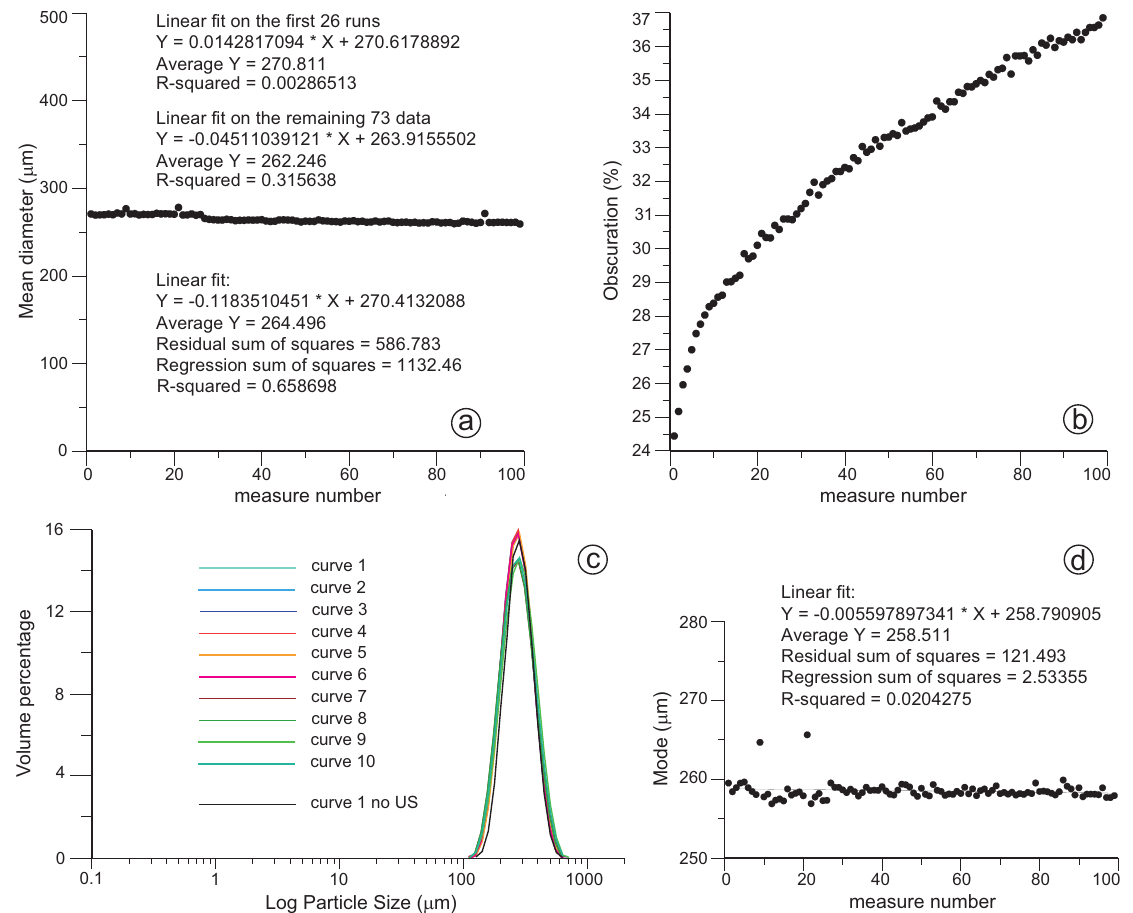
Fig. 15. Results of the ultrasonication test US20 5 performed on sub-sample aliquot SAND1d by the Hydro 2000 MU dispersion unit. (a) Mean diameter value evolution with increasing the number of measurement runs. Data statistics are provided for the cumulative dataset, for the first 26 runs, and for the remaining 73 runs, respectively. (b) Laser obscuration value progression during the same test. (c) Granulometric curves computed for the first 10 runs, compared with the first curve from the test MP2500 5 on sub-sample aliquot SAND1c (Fig. 8). Progression of modal values with increasing the number of measurement runs. Data statistics are